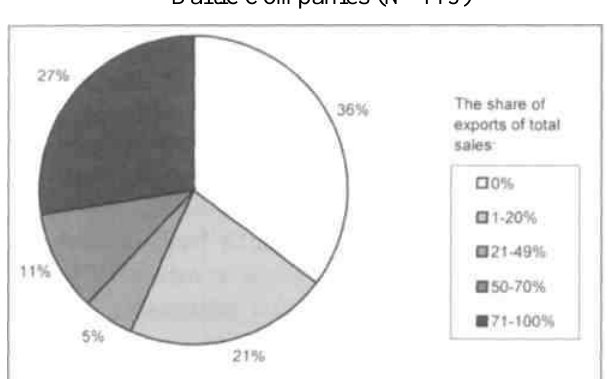
Table 6. The Share of Exports of the Total Sales in the Baltic Companies (N=113)